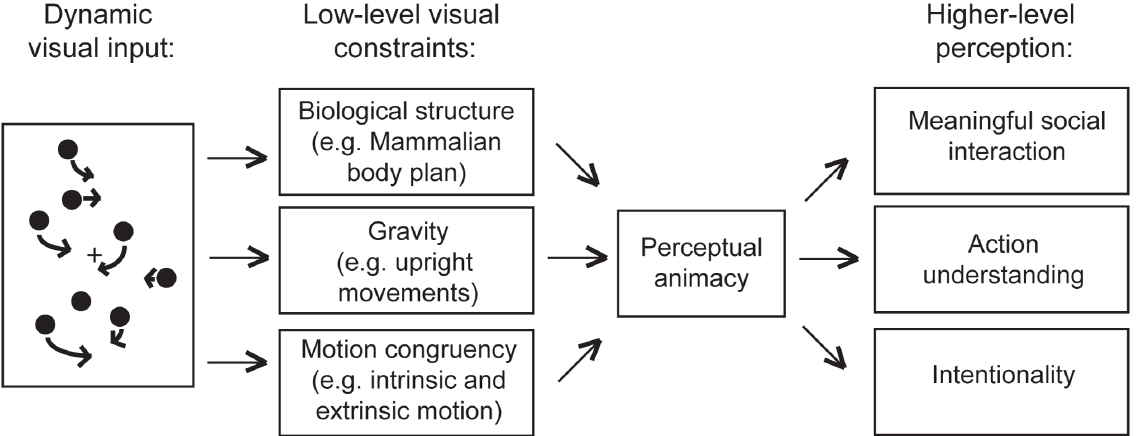
Figure 6. Schematic diagram of theoretical framework. When the visual system experiences a dynamic stimulus, its spatio-temporal properties are analyzed to confirm their consistency with basic constraints such as biological form, the influence of gravity, and the causal relationship between intrinsic limb movements and extrinsic body movements. These processes are relatively low-level and likely automatic or reflexive [22]. If the stimulus satisfies these constraints, it is perceived as animate and may pass on to higher-level analysis to evaluate its social significance.